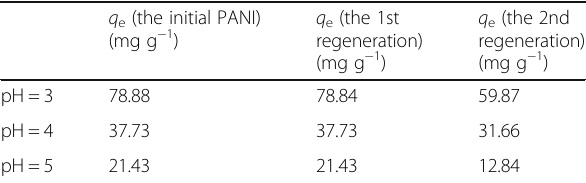
Table 2 Comparison of Cr (VI) removal capacity at equilibrium treated by hollow PANI micro/nanospheres before and after regeneration q e (the initial PANI) (mg g − 1